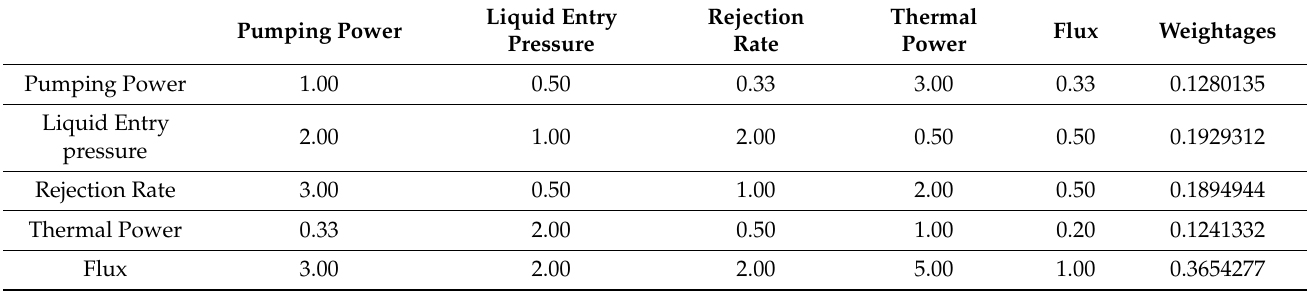
Table 2. Pairwise comparison of derivable outputs of MD using AHP-MDM by linguistic decision-maker (LDM)1.